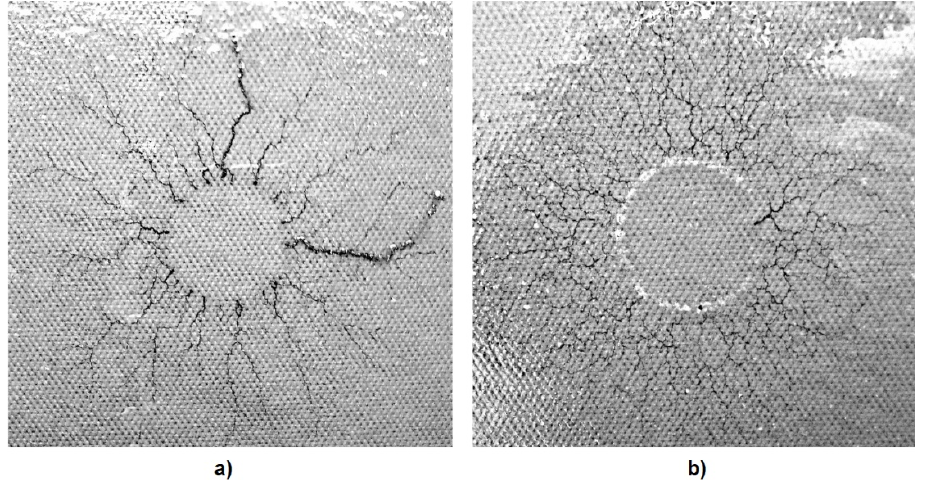
Figure 11. Differences in the shapes of marks due to discharges over the surface of pressboard samples: ( a ) mineral oil, ( b ) synthetic ester. ( a ) mineral oil, ( b ) synthetic